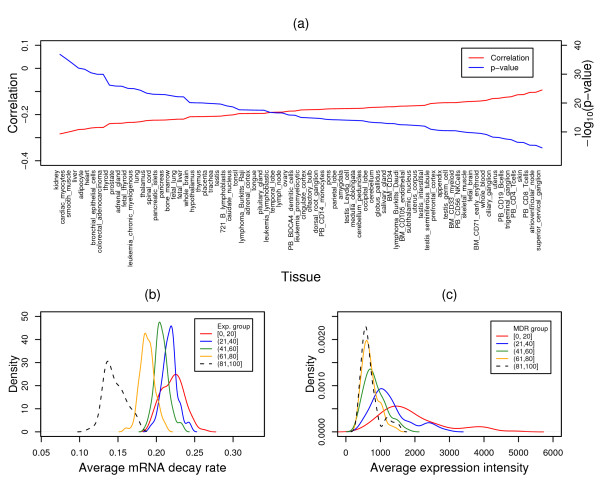
Correlation between mRNA expression and decay rate. (a) Spearman's rank correlation rho between gene expression from each of the 79 human tissues and mRNA decay rates, and corresponding p-values (-log10(p-values)) for the correlation coefficients. (b) Distribution of the average mRNA decay rates, which were obtained from comparing gene expression in each of the 79 human tissues, for 5 mRNA expression groups with increasing expression values from the group [1-20] to the group (81,100]. (c) Distribution of the average mRNA expression values in the 79 human tissues for 5 mRNA decay rate groups with increasing mRNA decay rate from the group [1-20] to the group (81,100]. Exp: mRNA expression; MDR: mRNA decay rate.